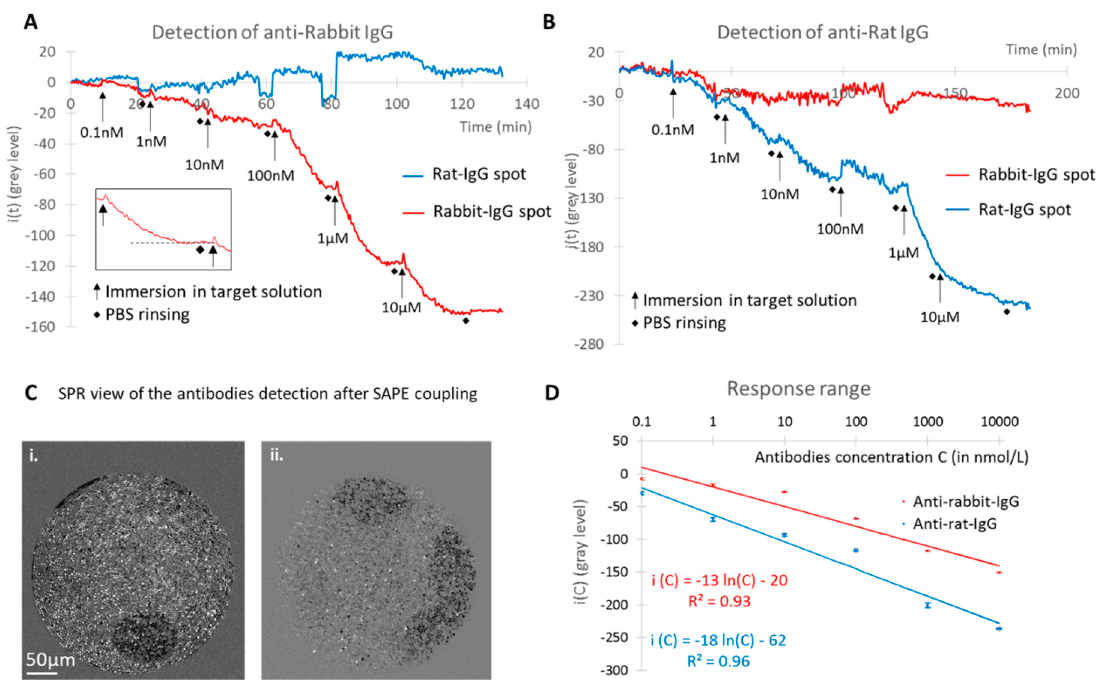
Figure 3. SPR signal ( i ( t ), in gray level) monitoring on the different spots of the bundle for the detection of ( A ) anti-rabbit IgG and ( B ) anti-rat IgG; ( C ) Surface Plasmon Resonance (SPR) images of the light retro-reflected on the fibers after injection of i. anti-rabbit IgG and ii. anti-rat IgG followed by coupling with streptavidin-phycoerythrin. ( D ) response range of the SPR signal on the different spots as a function of the corresponding specific antibodies concentration. Insert in A. zoom in one concentration of the curve, showing signal stabilization and rinsing in Phosphate-Buffered Saline (PBS).